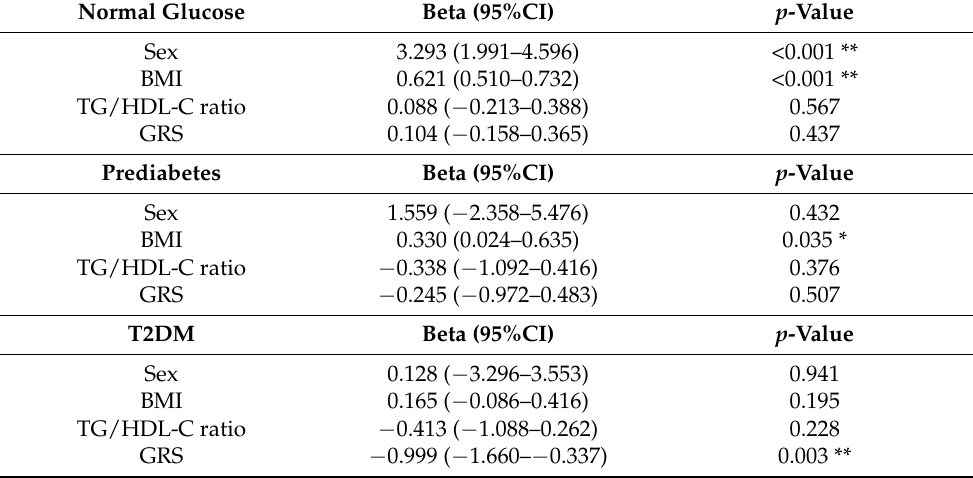
Table 5. Association of genetic risk scores (GRS) with age in subpopulations for T2DM ( n = 110), prediabetes ( n = 108), and people with normal glucose levels ( n = 1197). The association was evaluated by using adjusted linear regression models (sex, BMI, and TG/HDL-C ratio). Normal Glucose Beta (95%CI) p